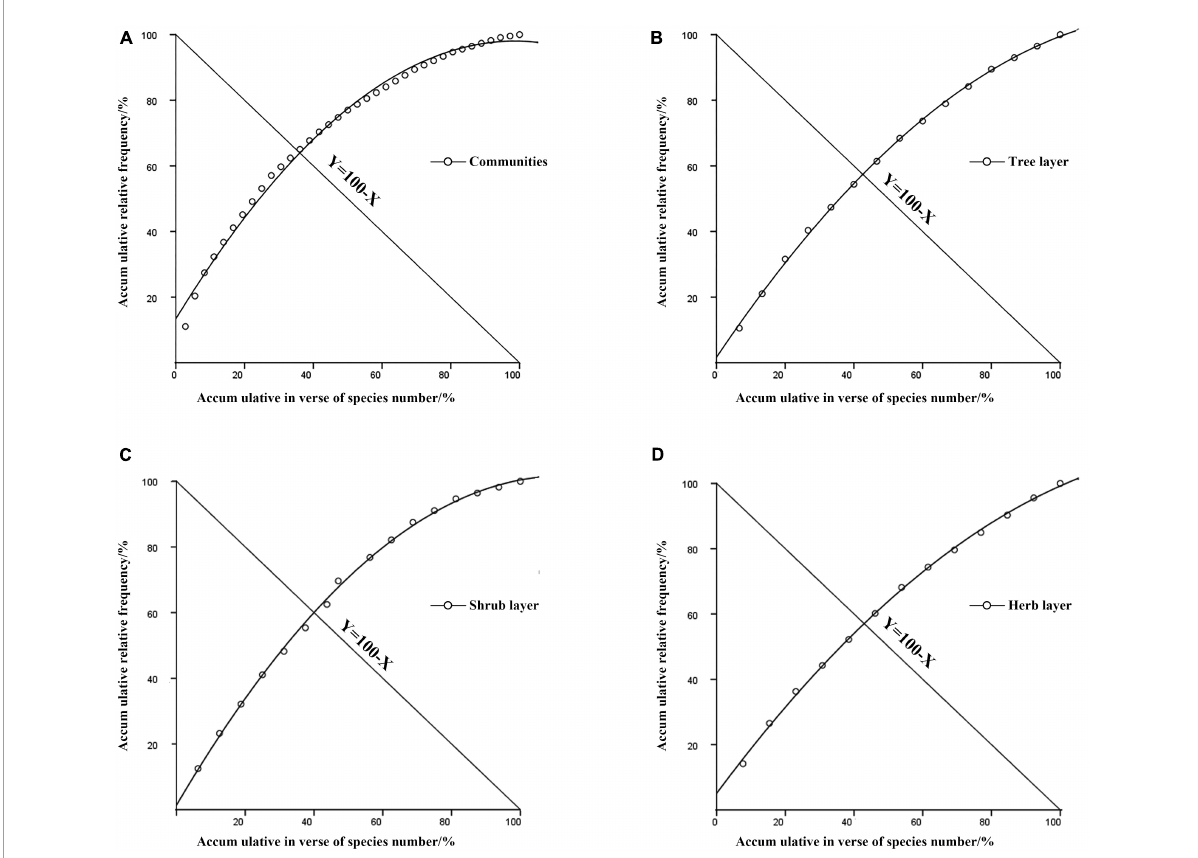
FIGURE2 Community stability graph of Hopea hainanensis. (A) Communities accum ultative in verse of species number. (B) Tree layer accum ultative in verse of species number. (C) Shrub layer accum ultative in verse of species number. (D) Herb layer accum ultative in verse of species